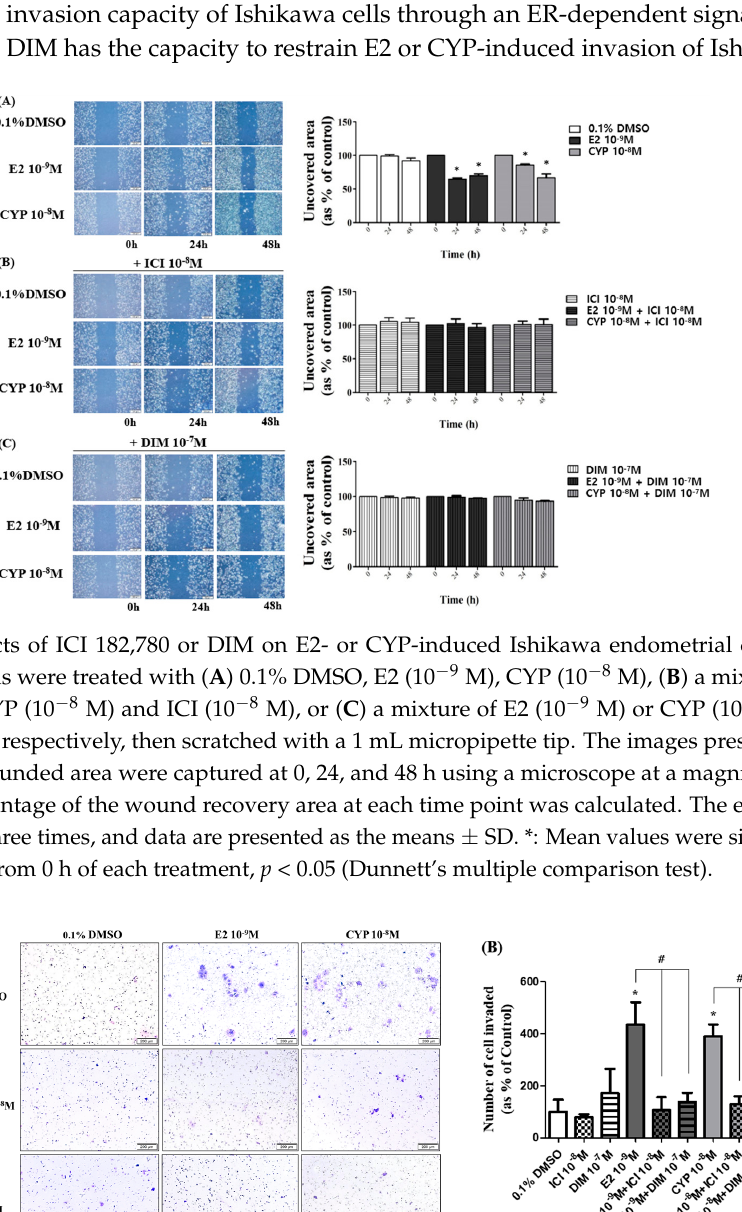
Figure 5. Effects of ICI 182,780 or DIM on E2- or CYP-induced Ishikawa endometrial cancer cell invasion. Ishikawa cells (1 × 10 5 cells) were cultured in transwells with the bottom surface covered with fibronectin in each well of a 24-well plate for 24 h. Cells were treated with 0.1% DMSO, E2 (10 − 9 M), CYP (10 − 8 M), a mixture of E2 (10 − 9 M) or CYP (10 − 8 M) and ICI (10 − 8 M) or a mixture of E2 (10 − 9 M) or CYP (10 − 8 M) and DIM (10 − 7 M), respectively, for 24 h. The cells attached to the bottom surface of the transwell were fixed with 10% formalin solution and stained with crystal violet. ( A ) The stained cells were detected under a microscope, and ( B ) the number of invading cells was counted. The experiment was repeated three times, and data were presented as the means ± SD. *: Mean values were significantly different from 0.1% DMSO (control), p < 0.05 (Dunnett’s multiple comparison test). #: Mean values of the mixture of ICI 182,780 or DIM and E2 and the mixture of ICI 182,780 or DIM and CYP were significantly reduced from E2 or CYP alone ( p < 0.05 according to Dunnett’s multiple comparison test).